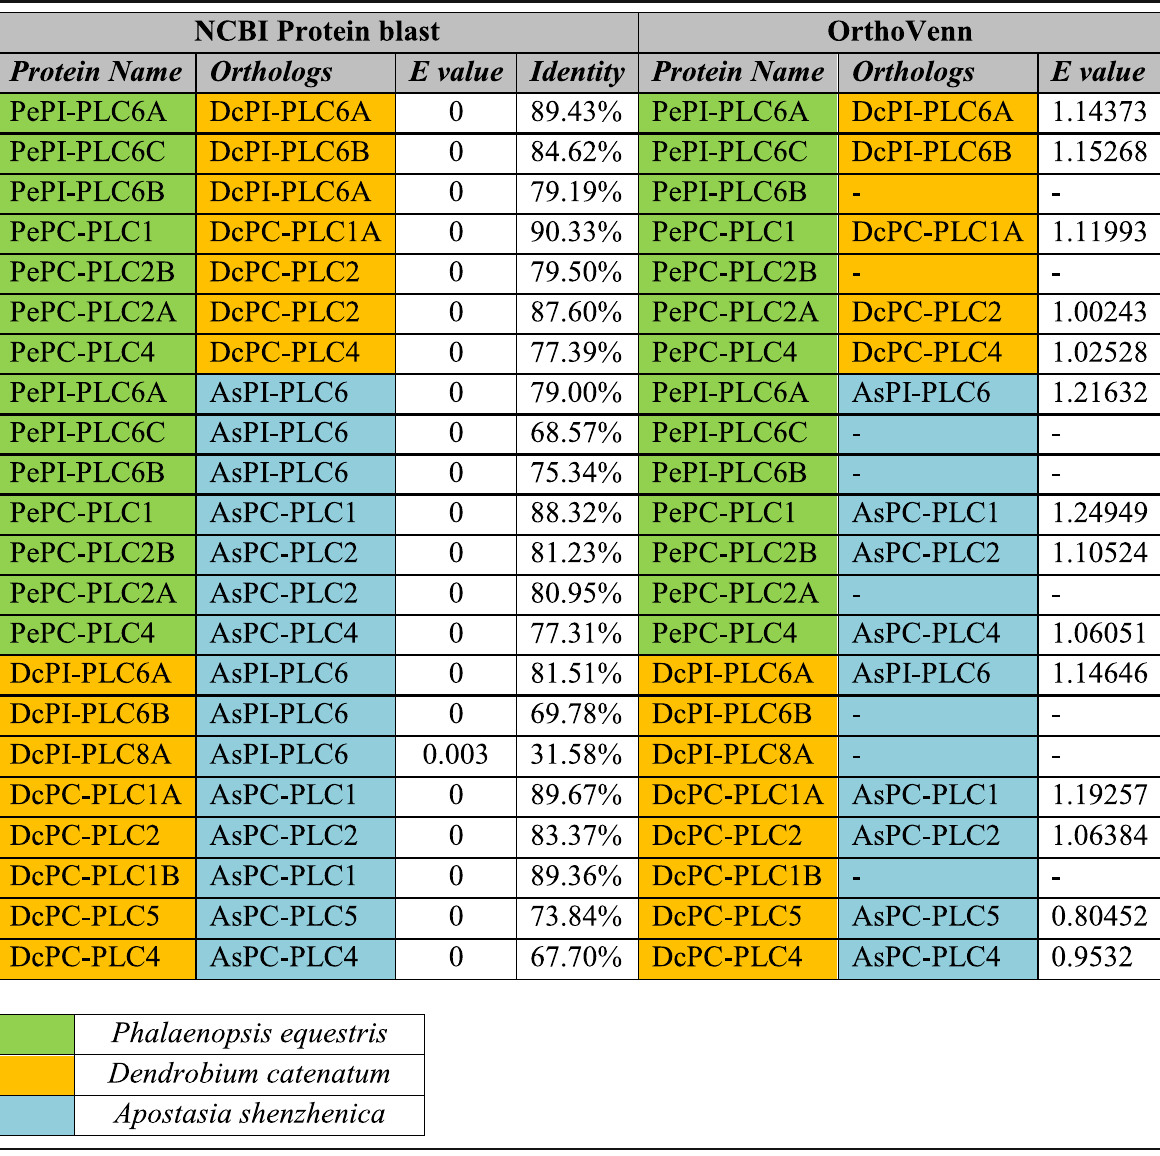
Table 1 Ortholog prediction for PePLC, DcPLC, and